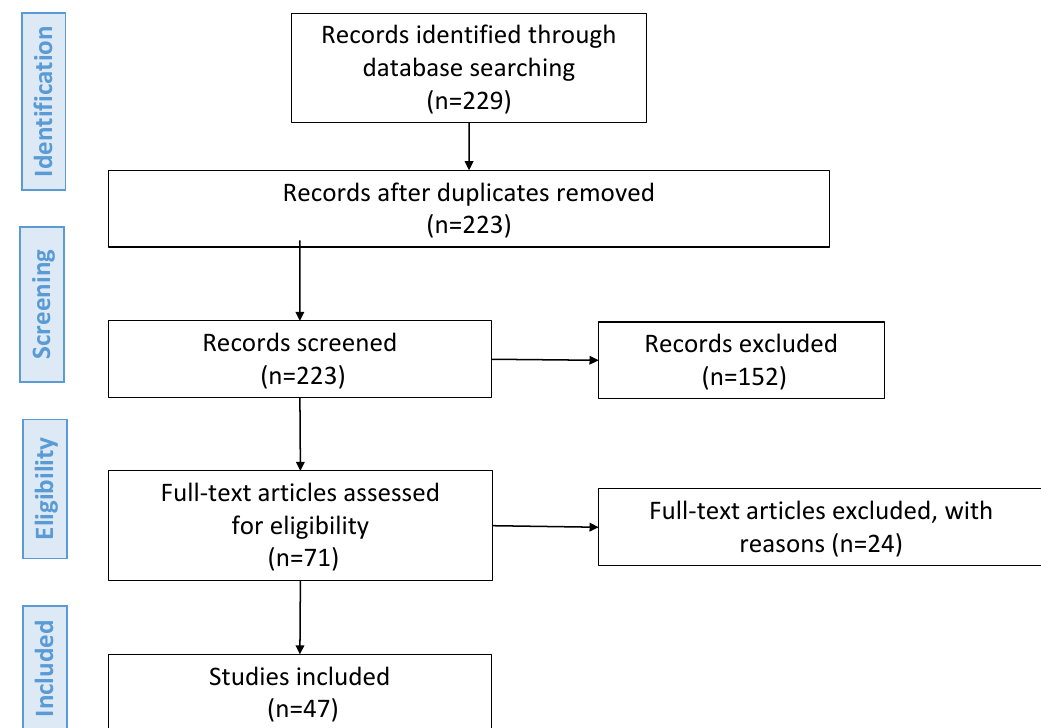
Figure 1. Flowchart of study search and review